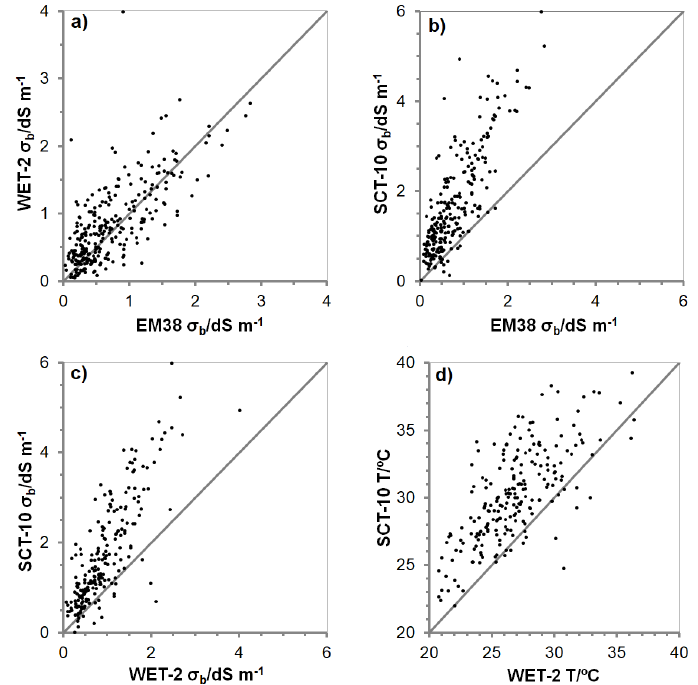
Figure 2. Comparison for all the sites and sampled soil layers (0–10, 10–30, 30–65, and 65–95 cm) of the soil bulk electrical conductivity ( σ b ) values calculated from the EM38 data and measured with the WET-2 and the SCT-10: ( a ) WET-2 vs. EM38 σ b values, ( b ) SCT-10 vs. EM38 σ b values, and ( c ) SCT-10 vs. WET-2 σ b values, as well as ( d ) the temperature values measured with the WET-2 and